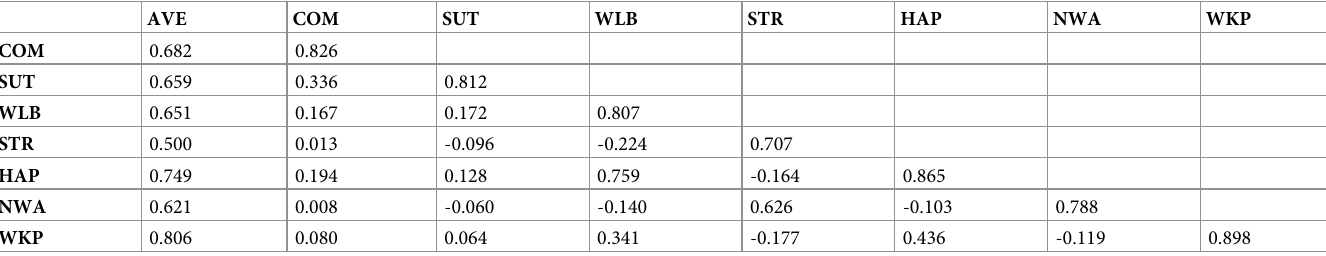
Table 3. Correlations of the